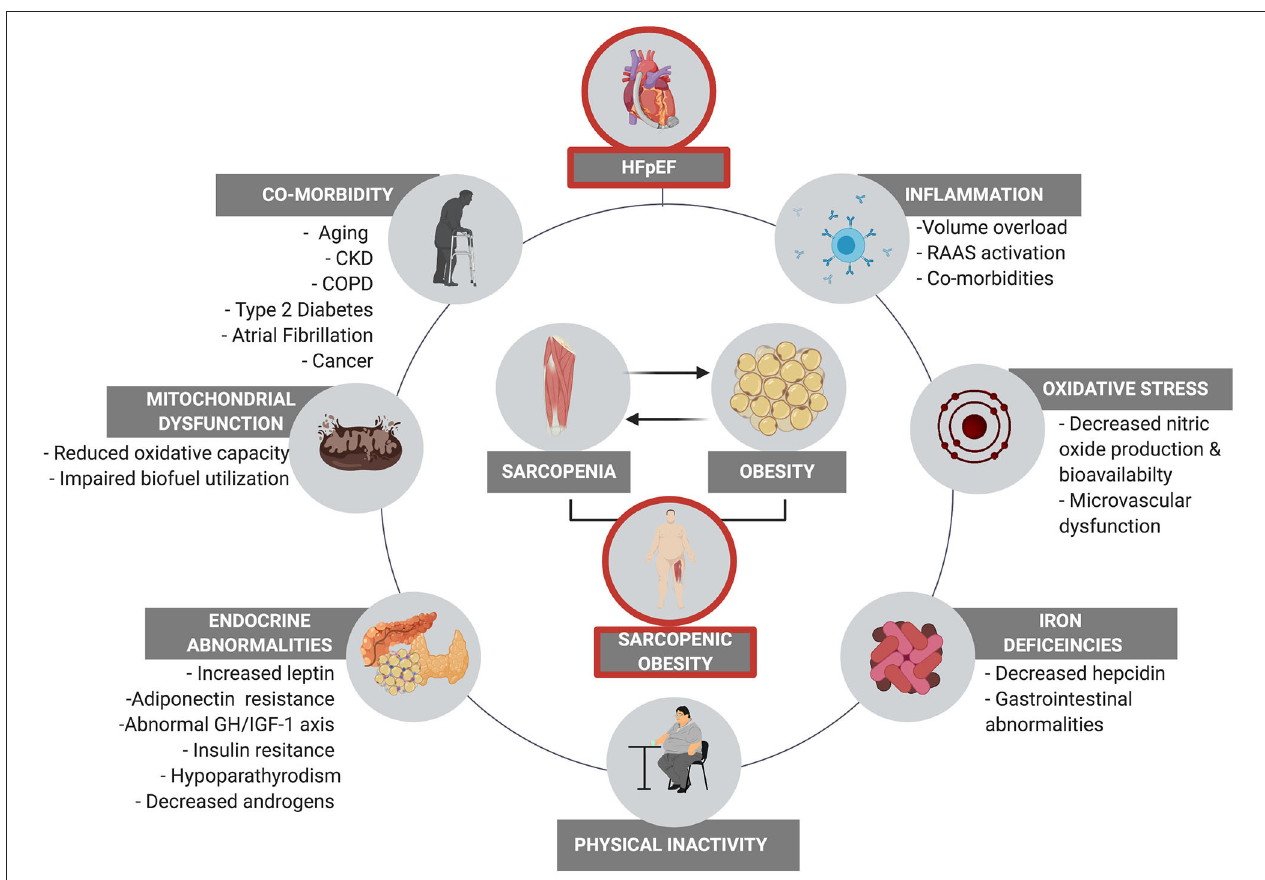
FIGURE 2 | The downward spiral of SO and physical inactivity that culminates in reduced quality of life, increased hospitalization, and mortality. Interventions targeting SO in HFpEF are urgently warranted to reverse the associated detrimental downstream